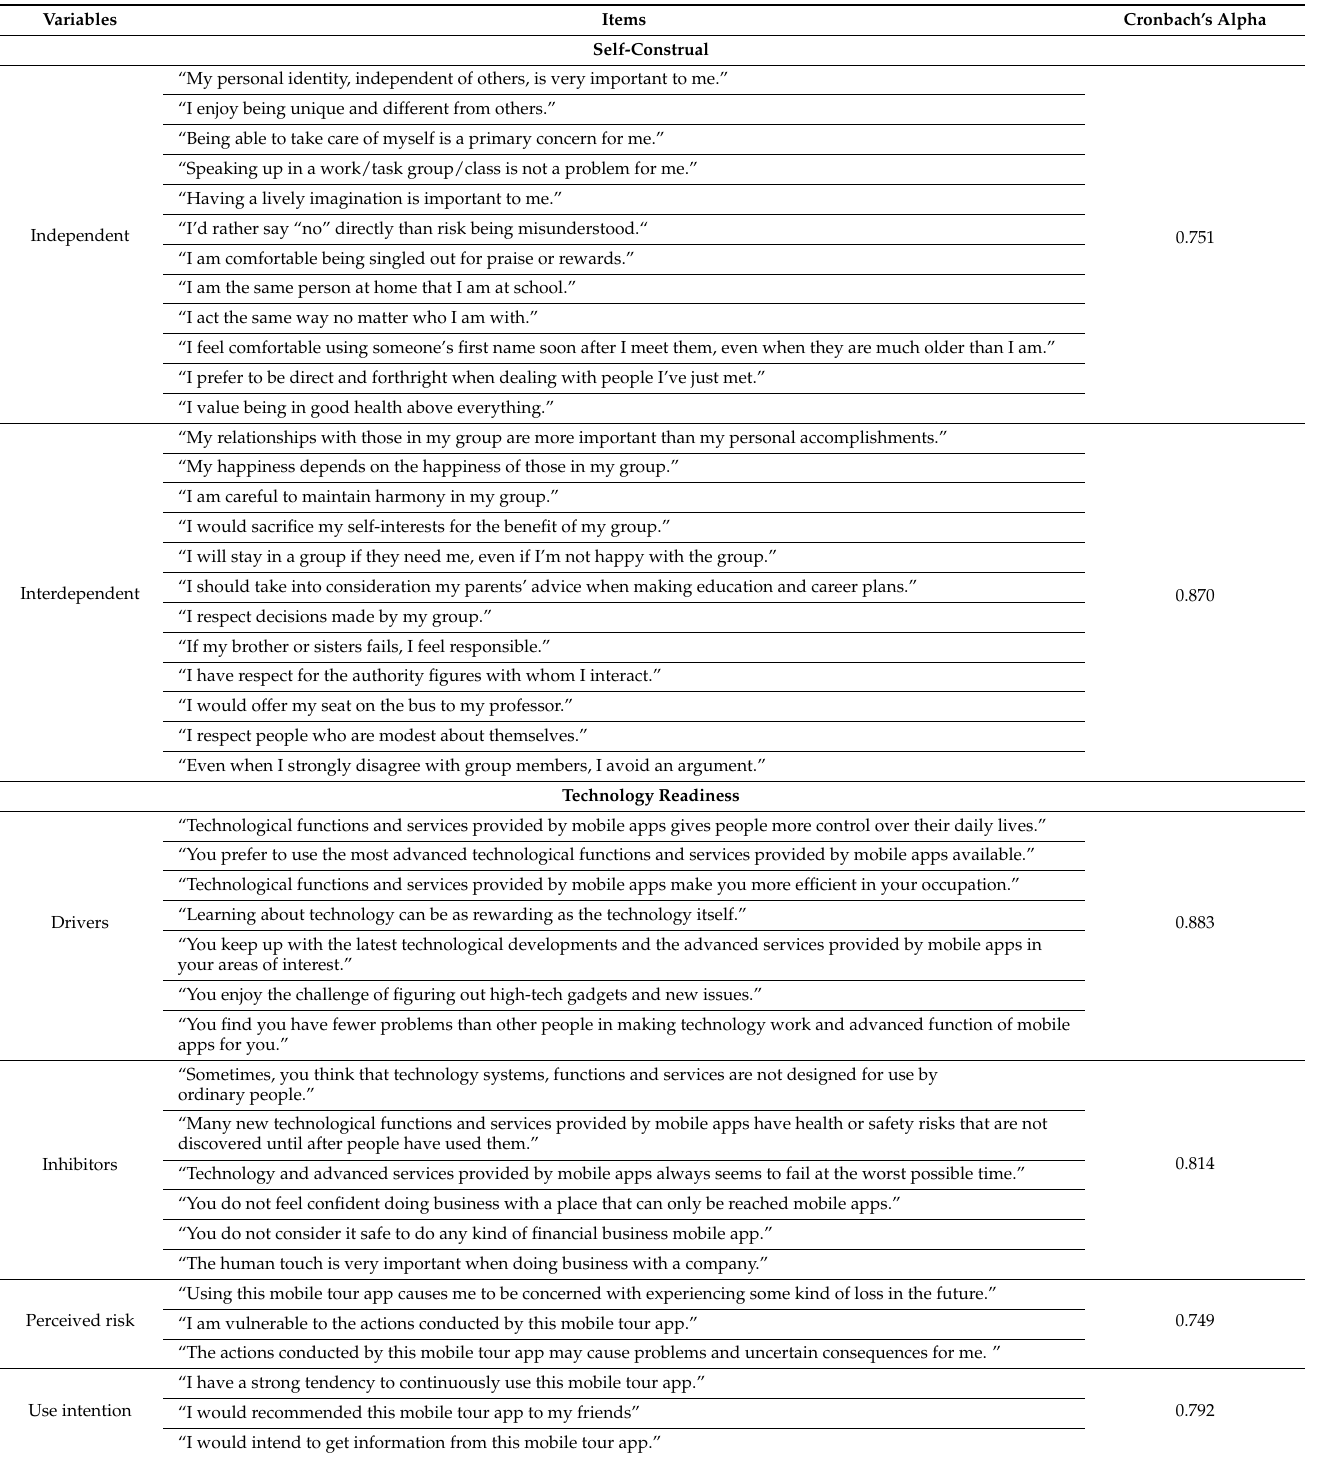
Table 2. Measurement